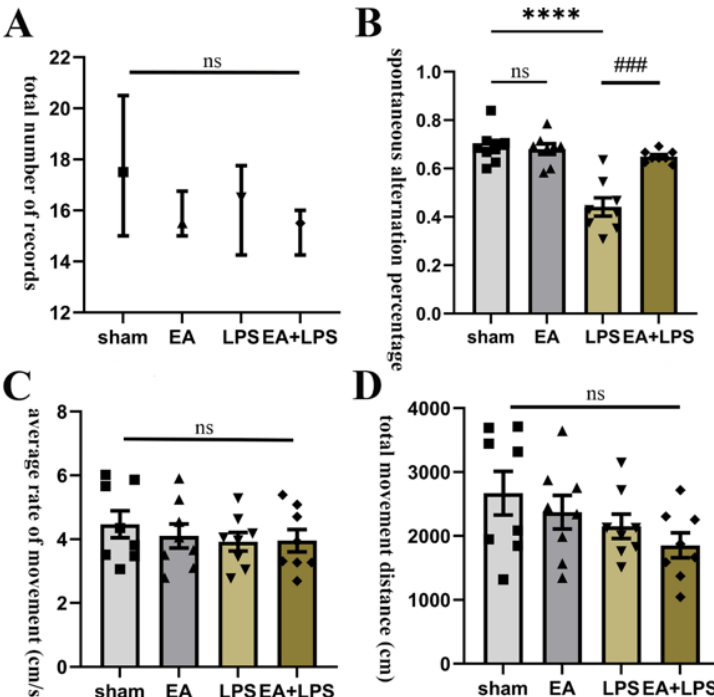
Figure 2. EA improved working memory tested by Y maze: n = 8 per group. ( A ) The total number of records in each group. ( B ) The spontaneous alternation percentage in each group. ( C ) The average rate of movement in each group. ( D ) The total movement distance in each group. Data are presented as median and interquartile range and means ± SEM. Compared with the sham group, **** p < 0.0001; compared with the LPS group, ### p < 0.001. , , , : Represents the individual value of the rats in each group. Abbreviations: EA, electroacupuncture; LPS, lipopolysaccharide; ns, no significant